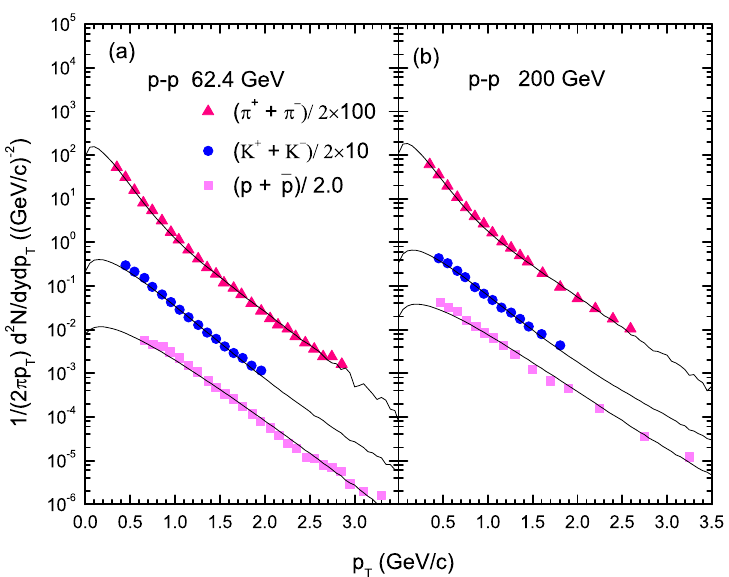
Figure 2. (Color online) Transverse momentum spectra of identified charged hadrons (pions, kaons, √ s NN = 62.4 and 200 GeV. Experimental data from the PHENIX Collabo- protons) in pp collisions at ration [15–17] and the STAR Collaboration [18,19] are shown by the scattered symbols. The model results are shown by the solid line.